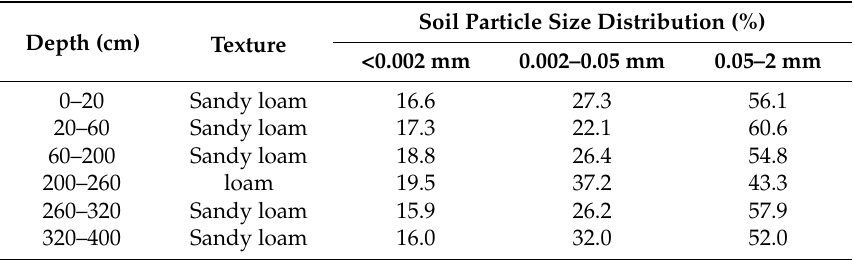
Table 1. Soil texture and particle size distribution in Hebei Low Plains in North China.